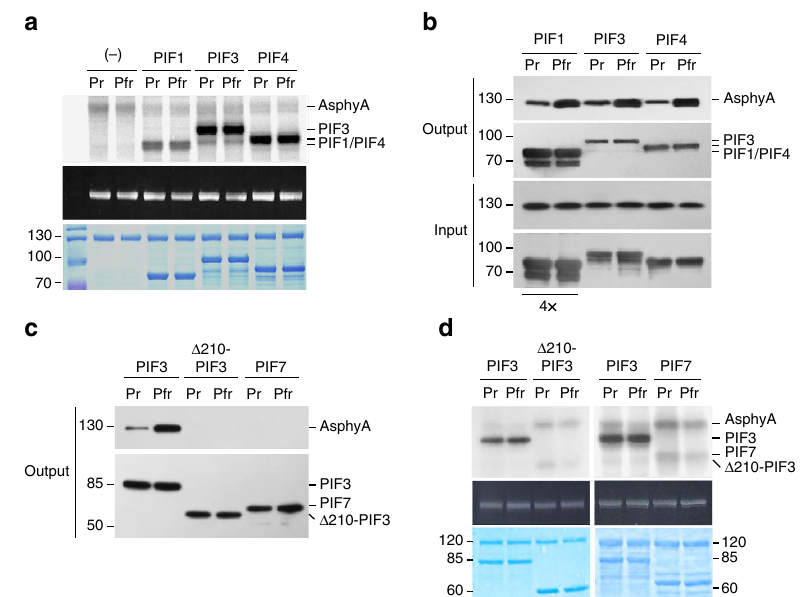
Figure 2 | Analysis of AsphyA-PIF interactions and kinase activity. ( a ) Protein kinase activities of AsphyA on other PIFs. In all, 1 m g of full-length AsphyA ( B 0.2 m M) and 1 m g of each phyA-interacting PIF (PIF1, PIF3 and PIF4 as substrates) were used for this analysis. AsphyA autophosphorylation without substrate was included as a control. ( b ) Interaction of AsphyA with PIF1, PIF3 and PIF4. The concentration of PIF1 proteins used in this assay was four times higher than that of PIF3 and PIF4. Both Pr and Pfr forms of full-length AsphyA proteins were incubated with PIFs, and glutathione bead-bound proteins were then analysed by western blot analysis with anti-AsphyA (oat22) or anti-GST antibody. ( c ) Protein–protein interaction analysis between AsphyA and APA/APB motif-deleted PIF3 ( D 210-PIF3) or PIF7. ( d ) Phosphorylation of D 210-PIF3 and PIF7 by AsphyA. PIF3 was included as controls. APA, active phyA-binding motif; APB, active phyB-binding